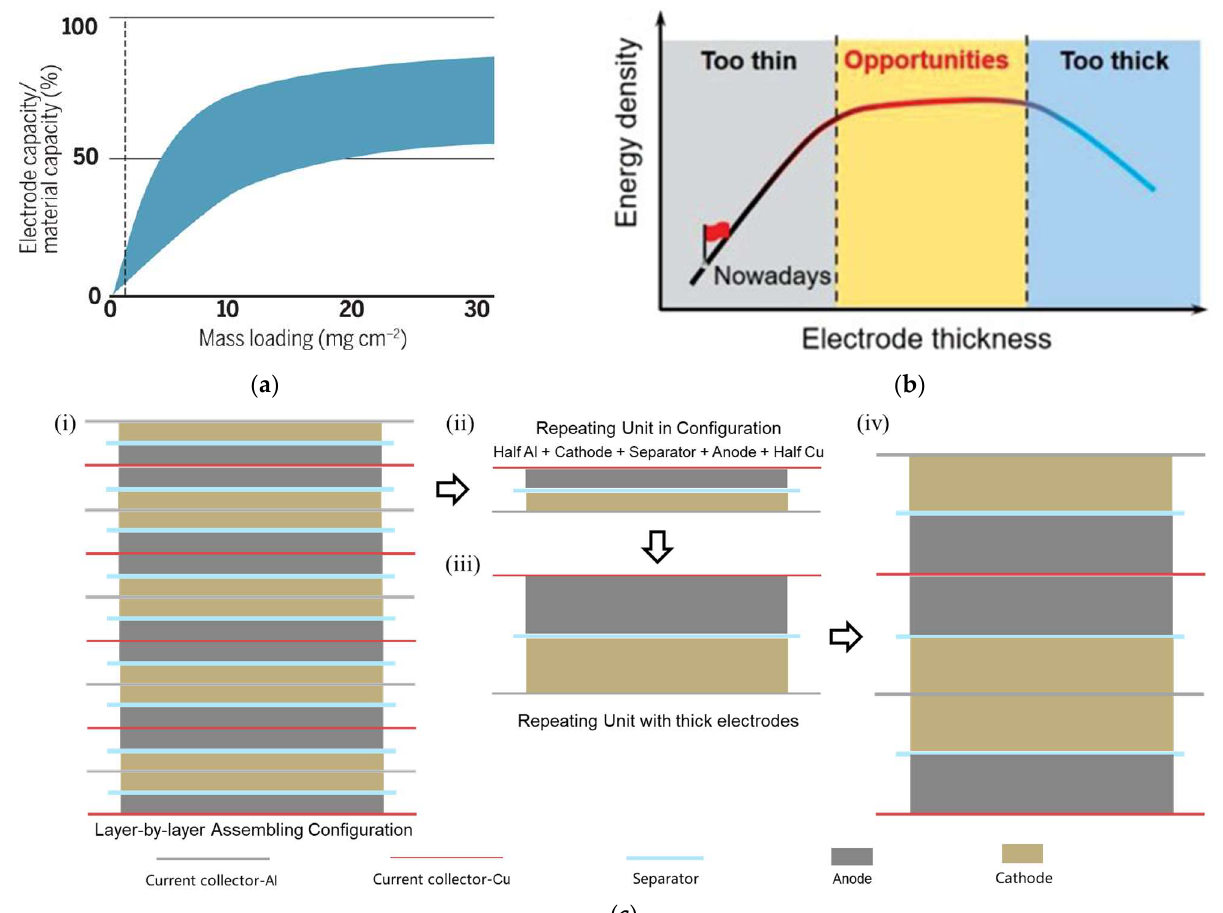
Figure 2. ( a ) The capacity of an electrode is positively proportional to the mass loading of active materials on the electrode [12]. ( b ) A detailed explanation about thick electrode design. ( c ) The opportunities for thick electrode design [13].